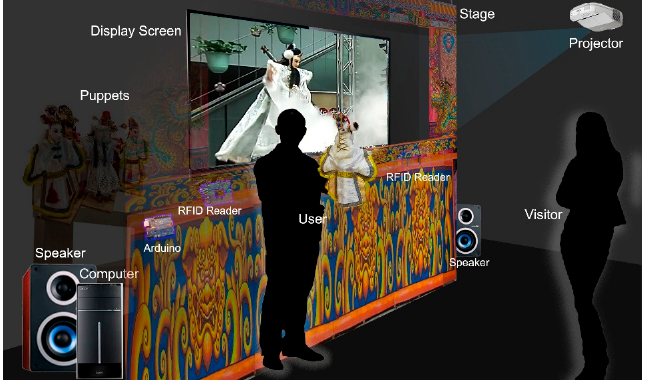
Figure 5. An illustration of the environment setup of the proposed interactive role-play system, which also shows the user is learning an expert’s performance shown in a video clip played on the background screen (note: the puppet’s face is toward the background screen).